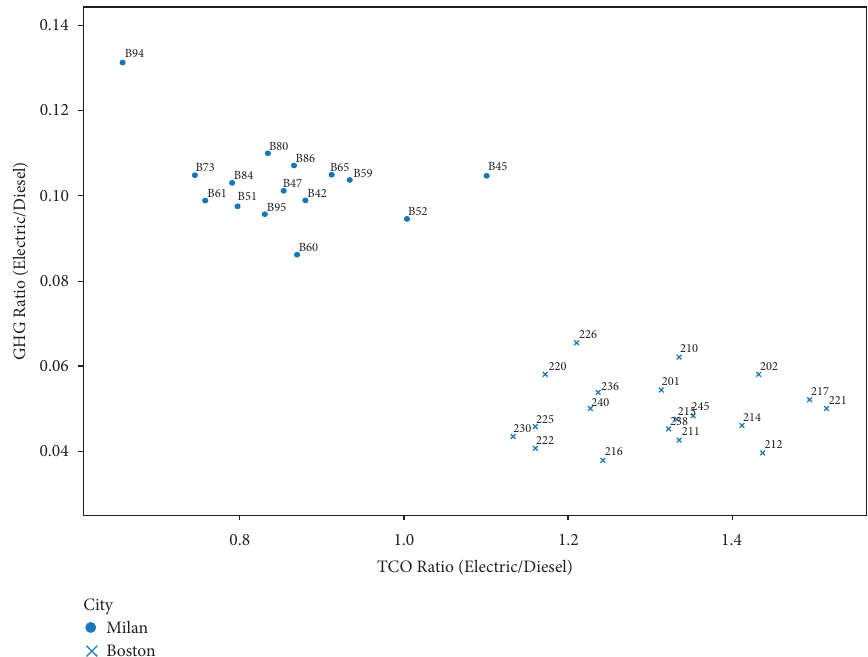
Figure 13: Total cost of ownership and greenhouse gas emissions as a ratio of electric buses to diesel buses.